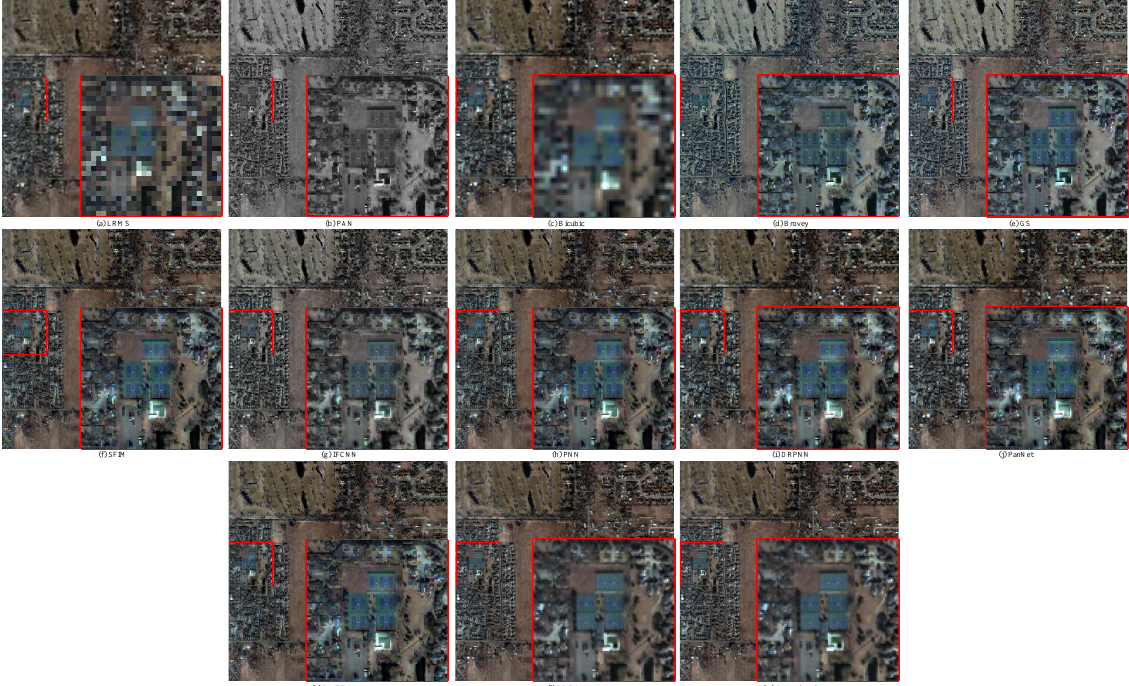
Figure 16. Subjective comparison between RDFNet and the current mainstream fusion methods for testing dataset fusion results of QuickBird with reduced resolution. ( a ) LRMS; ( b ) PAN; ( c ) Bicubic; ( d ) Brovey; ( e ) GS; ( f ) SFIM; ( g ) IFCNN; ( h ) PNN; ( i ) DRPNN; ( j ) PanNet; ( k ) ResTFNet; ( l ) RDFNet (ours); ( m ) ground